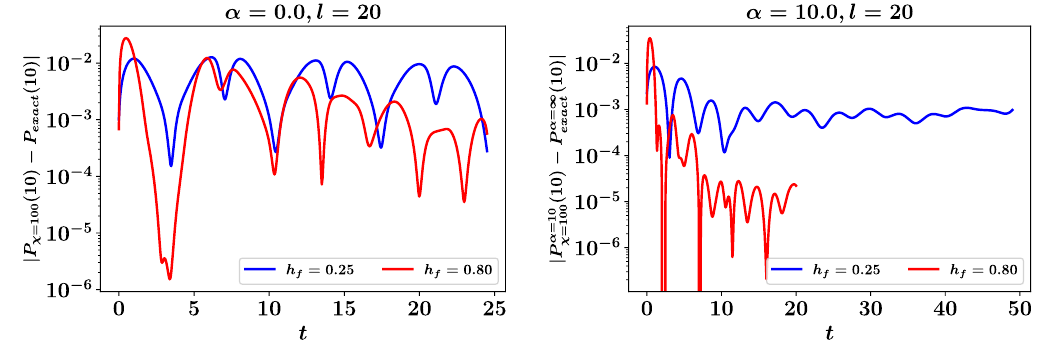
Figure 12: Errors in emptiness formation probability computed with bond dimension χ = 100 with respect to the exact analytical and numerical results at two extremes of the long range Ising model for quenches to two values of final transverse fields. On the left panel the error is computed by subtracting the exact diagonalization results with the TDVP results, refer to figure 9. On the right panel the error is computed by subtracting the exact analytical results with the TDVP results computed for suffi- ciently large interaction range, α = 10, refer to figure